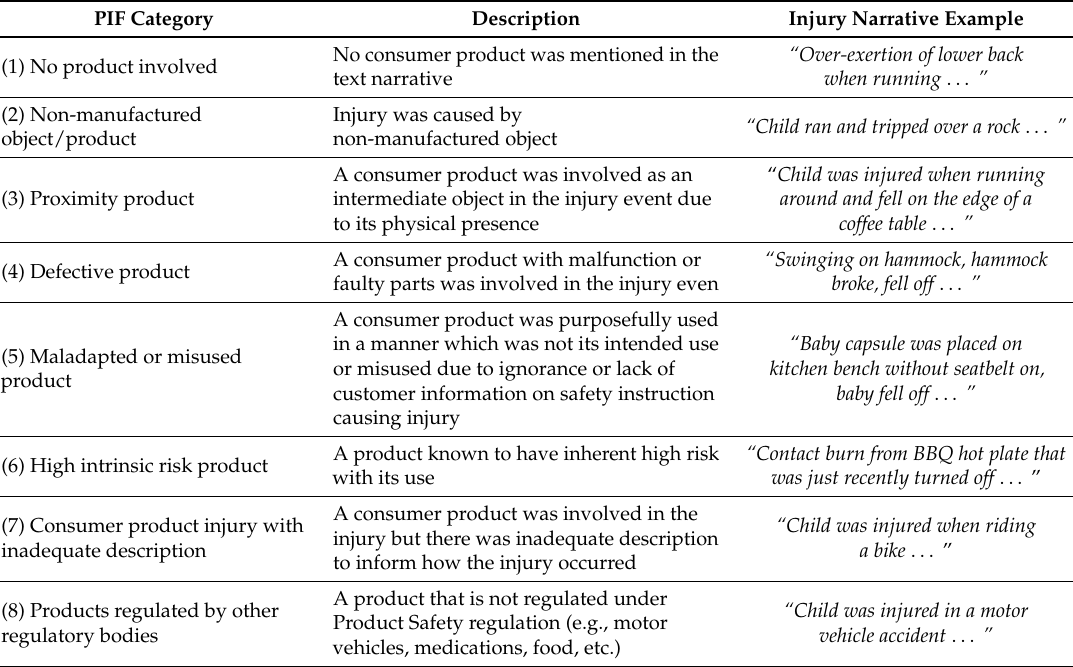
Table 1. Product involvement factor categories and